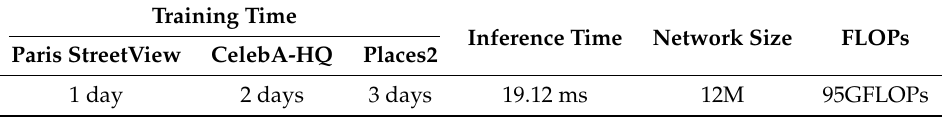
Table 4. Measurement of the computational complexity of the proposed network.